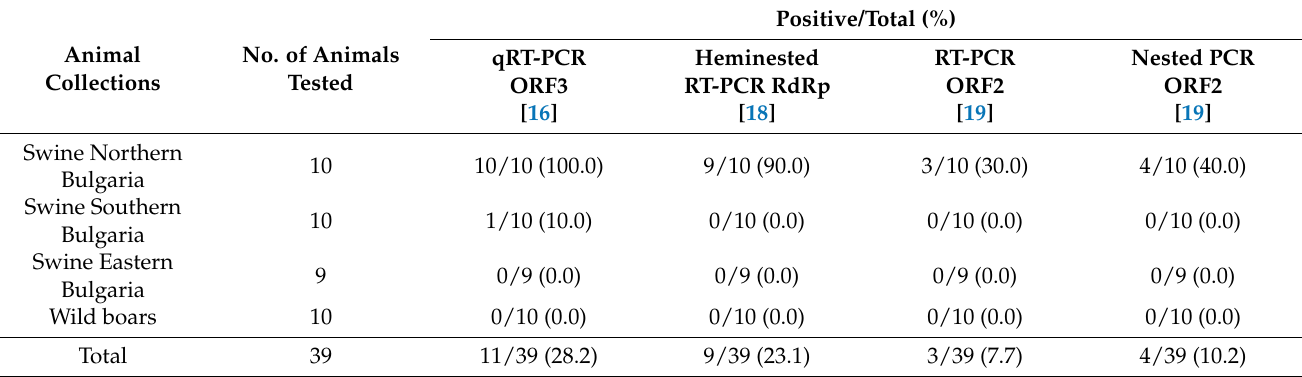
Table 2. Molecular prevalence of HEV in sera collected form pigs and wild boars in Bulgaria.